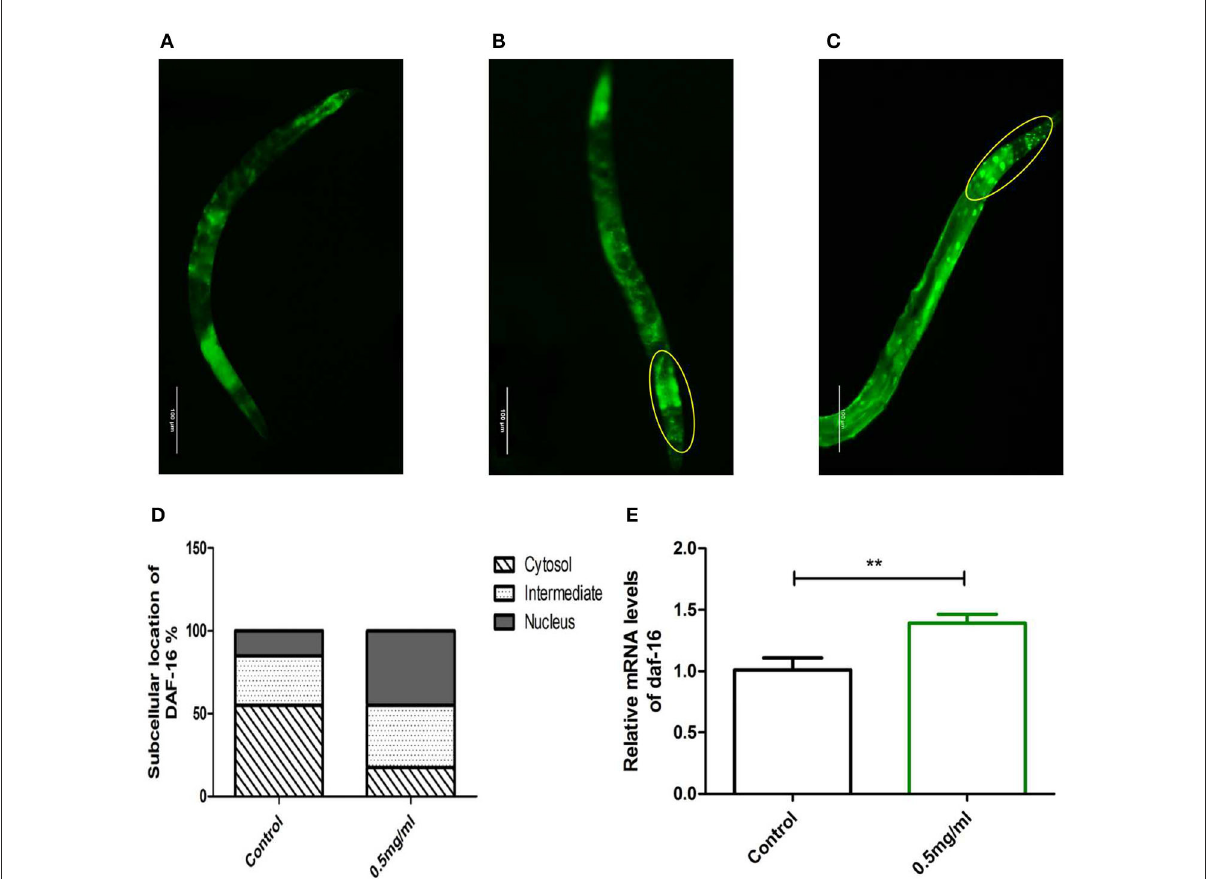
FIGURE8 The effect of Exendin-4 on DAF-16. The subcellular distribution of DAF-16 was examined in approximately 20 worms for each group by fluorescence microscopy. (A) Cytosol, (B) intermediate, (C) nucleus, and (D) the treated worms with 0.5 mg/ml Exendin-4 significantly increase the ratio of nucleus translocation. The histogram represents the ratio of each subcellular distribution in the whole population in each group. (E) The mRNA levels of daf-16 were analyzed by real-time PCR. mRNA levels was increased by 69.00% ( p <